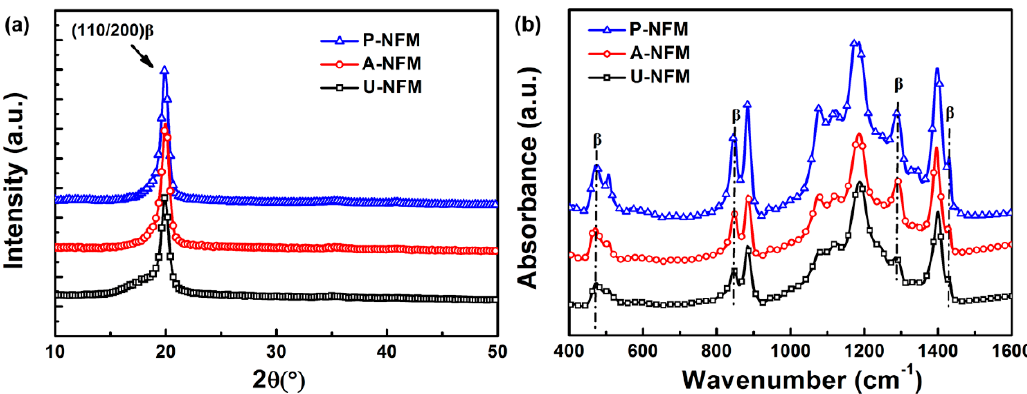
Figure 2. Crystalline characterization of P(VDF-TrFE) NFMs treated with different postprocessing